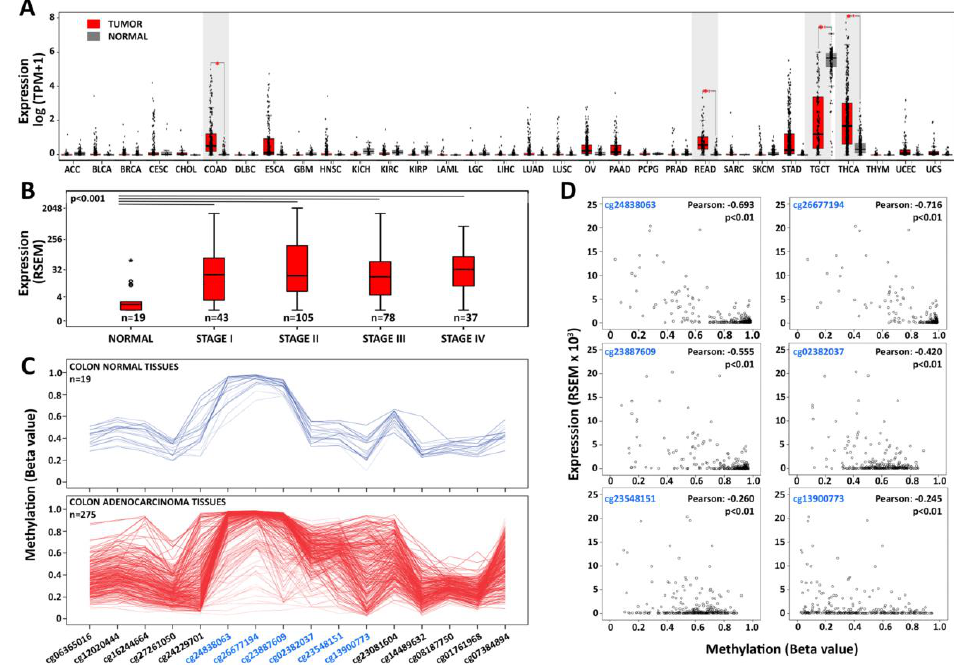
Figure 1. The germline-specific PIWIL1 gene is ectopically activated in colorectal cancer. ( A ) Integrative analysis of The Cancer Genome Atlas (TCGA) and the Genotype-Tissue Expression GTEx data showed that PIWIL1 , abundantly expressed in the germline (TCGC, normal), is aberrantly activated in cancer and significantly upregulated (highlighted in grey) in colon (COAD), rectum (READ), and thyroid carcinomas (THCA) with respect to the normal tissue (log 2 (median (Tumor)–median (Normal)) > 0.5; p value < 0.01). Expression levels are displayed in log 2 -transformed (TPM (transcripts per million) + 1). ACC: adrenocortical carcinoma; BLCA: bladder urothelial carcinoma; BRCA: breast invasive carcinoma; CESC: cervical squamous cell carcinoma and endocervical adenocarcinoma; CHOL: cholangio carcinoma; COAD: colon adenocarcinoma; DLBC: lymphoid neoplasm di ff use large B-cell lymphoma; ESCA: esophageal carcinoma; GBM: glioblastoma multiforme; HNSC: head and neck squamous cell carcinoma; KICH: kidney chromophobe; KIRC: kidney renal clear cell carcinoma; KIRP: kidney renal papillary cell carcinoma; LAML: acute myeloid leukemia; LGG: brain lower grade glioma; LIHC: liver hepatocellular carcinoma; LUAD: lung adenocarcinoma; LUSC: lung squamous cell carcinoma; OV: ovarian serous cystadenocarcinoma; PAAD: pancreatic adenocarcinoma; PCPG: pheochromocytoma and paraganglioma; PRAD: prostate adenocarcinoma; READ: rectum adenocarcinoma; SARC: sarcoma; SKCM: skin cutaneous melanoma; STAD: stomach adenocarcinoma; TGCT: testicular germ cell tumor; THCA: thyroid carcinoma; THYM: thymoma; UCEC: uterine corpus endometrial carcinoma; UCS: uterine carcinosarcoma. ( B ) Boxplots showing the expression of PIWIL1 across di ff erent AJCC (American Joint Committee on Cancer) stages of TCGA colon adenocarcinomas. ( C ) DNA methylation profile of CpGs in the promoter region of PIWIL1 in colon normal tissues (in blue) and adenocarcinomas (in red); CpG sites highlighted in blue constitute a CpG island and are strongly methylated in colon normal tissues, while lower methylation levels are observed in several tumors. ( D ) Statistically significant negative correlation between PIWIL1 expression and DNA methylation at CpG sites hypomethylated in tumors; beta values are plotted on the x -axis and RSEM (RNA-Seq by expectation-maximization) gene expression values on the y